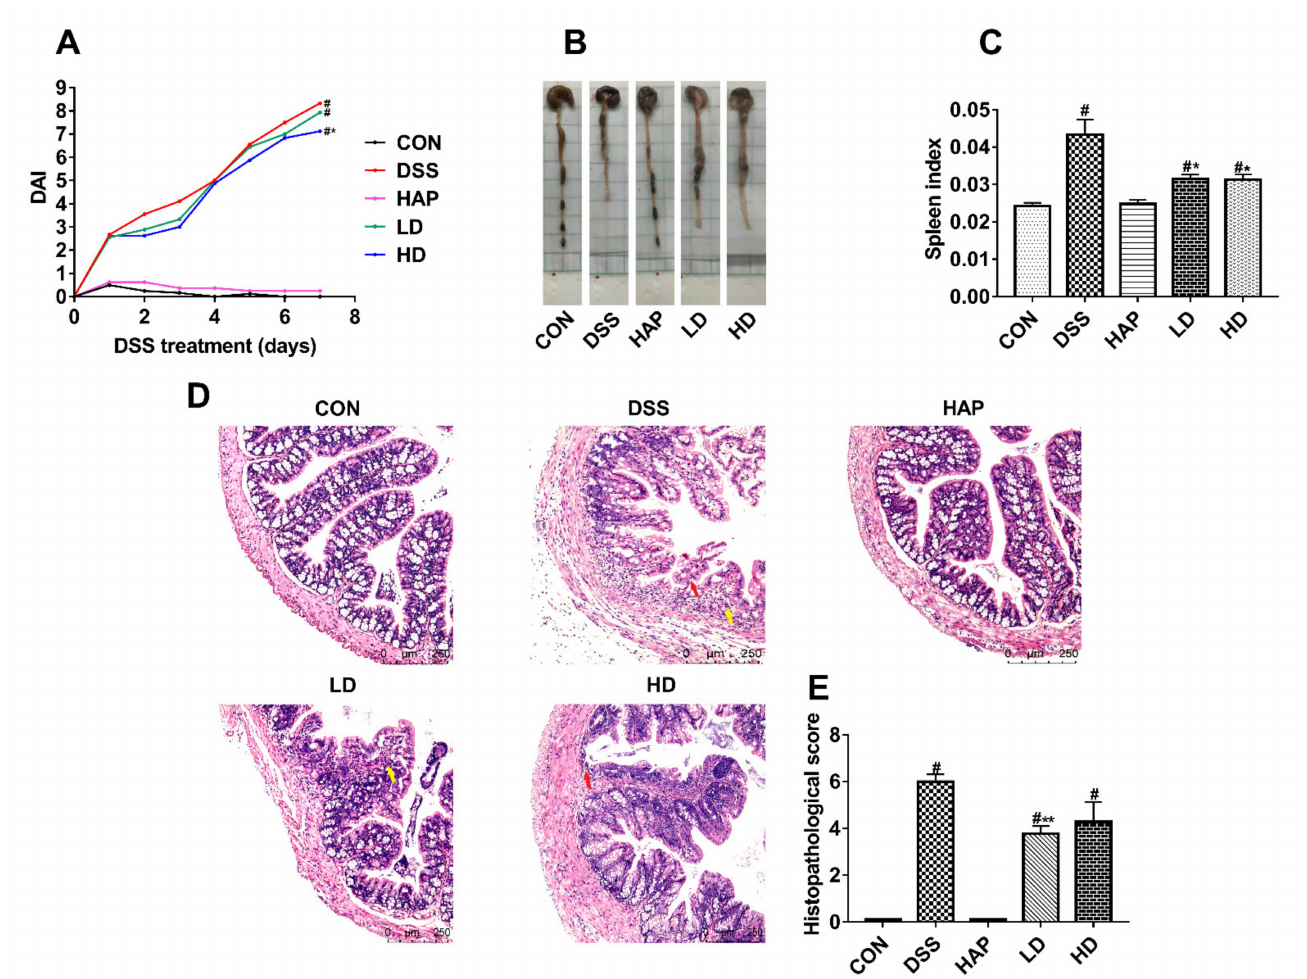
Figure 2. Effect of APE on the symptoms of DSS-induced acute ulcerative colitis (UC): ( A ) Disease activity index (DAI) scores. ( B ) Representative pictures of colon. ( C ) Spleen index. ( D ) Representative image of Hematoxylin and eosin (H&E) staining at 20 × resolution. ( E ) Histopathological scores. Red arrows indicated tissue local mucosal damage. Yellow arrows represented inflammatory cell infiltration. n = 8 or 9. # p < 0.05 vs. CON group. * p < 0.05 vs. DSS group. ** p < 0.01 vs. DSS